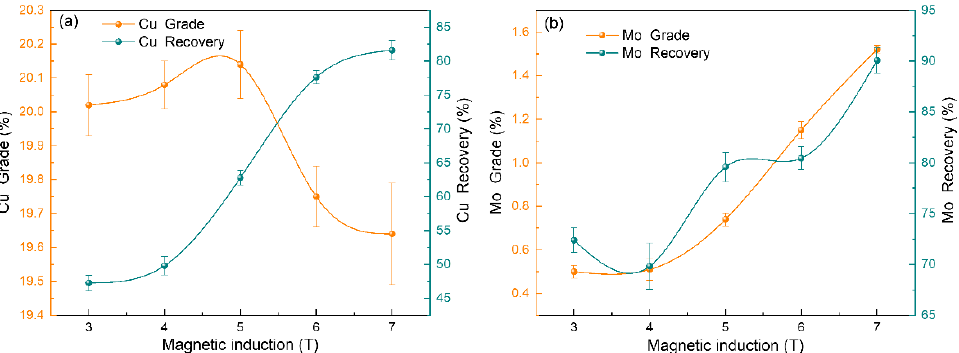
Figure 5. Effect of magnetic induction on the separation performance of the superconducting sepa- rator at a pulp concentration of 20% and a feed velocity of 4 L/min. ( a ) Cu recovery from magnetic products; ( b ) Mo recovery from non-magnetic products.